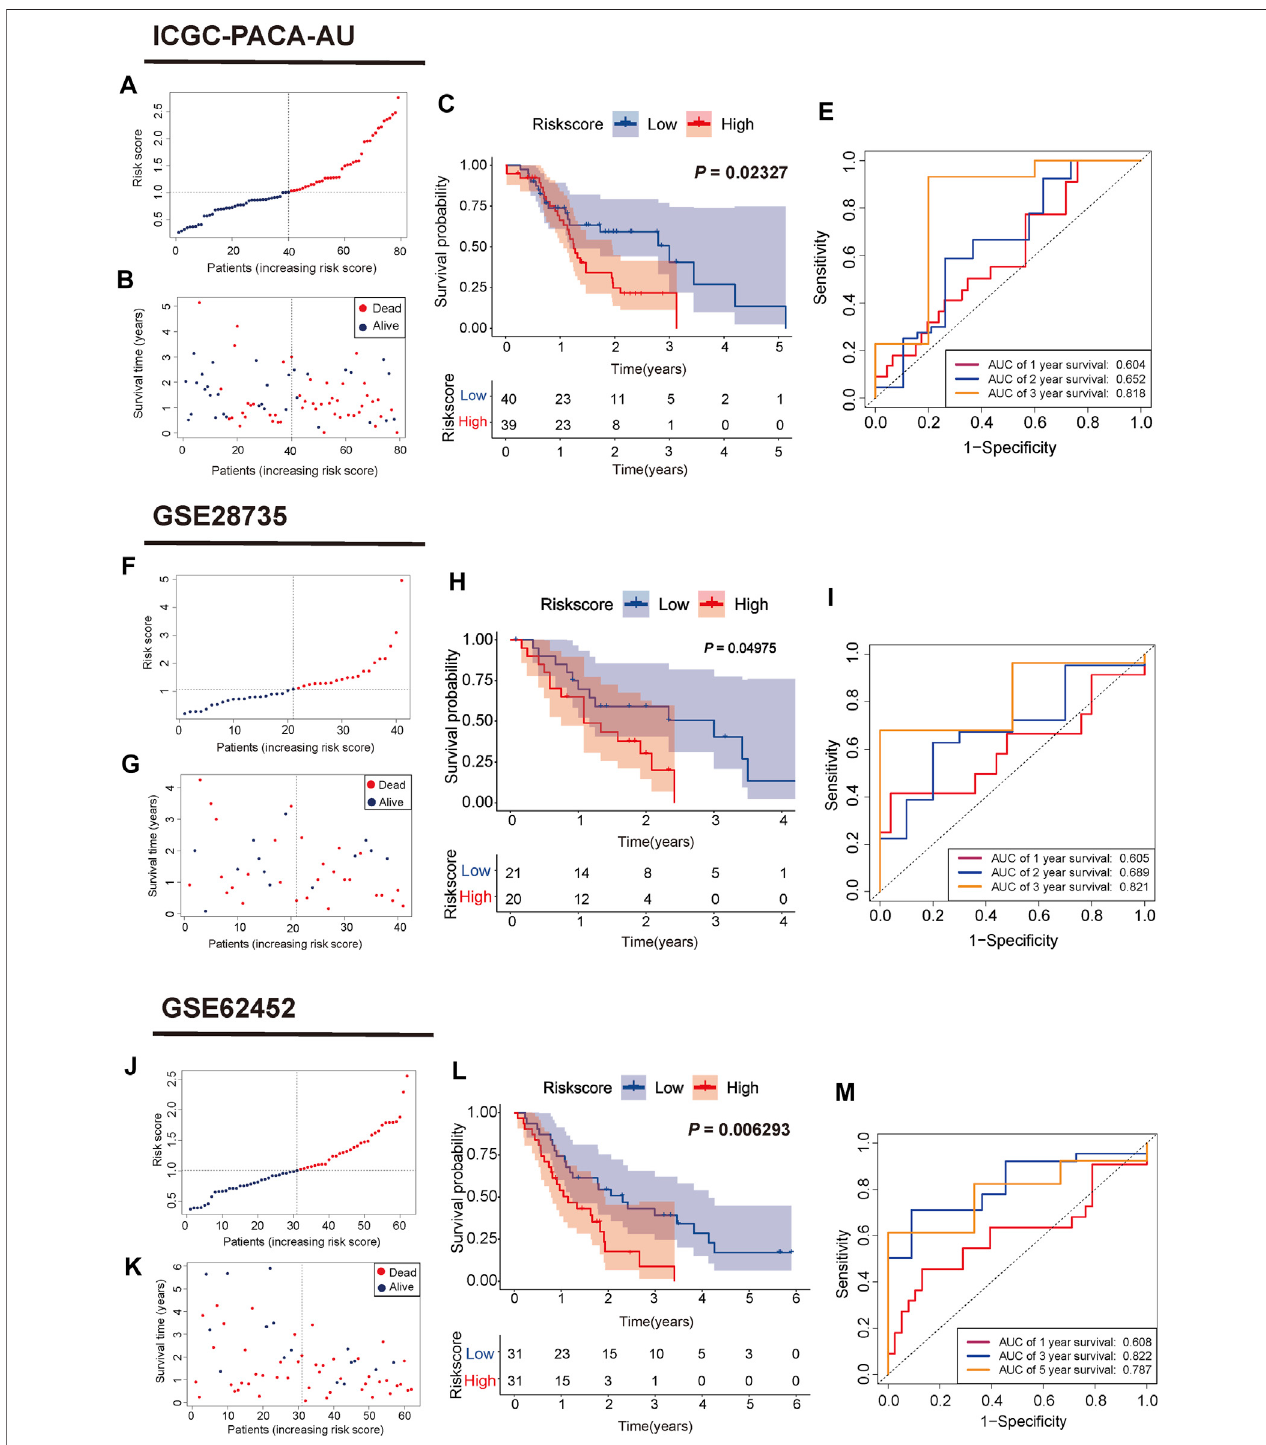
FIGURE 4 | Validation of the mitophagy-related gene signature in ICGC, GSE28735, GSE62452 cohorts (A,F,J) Distribution of risk score for each PC sample (B,G,K) Survivaltimeand statusof each PC sample based on the risk score (C,H,L) Survivalanalysisbetween thetwo risksubgroups (E, I,M) ROCcurveofthe 3-gene